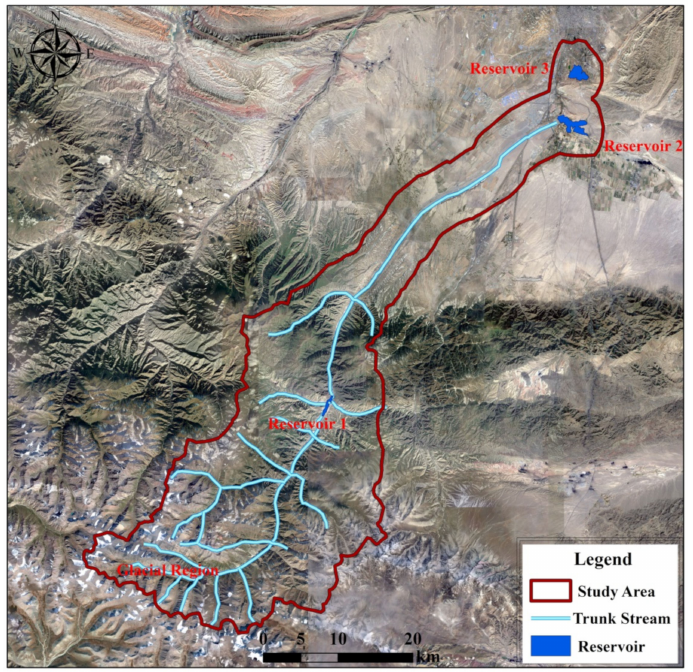
Figure 2. Overview of the study